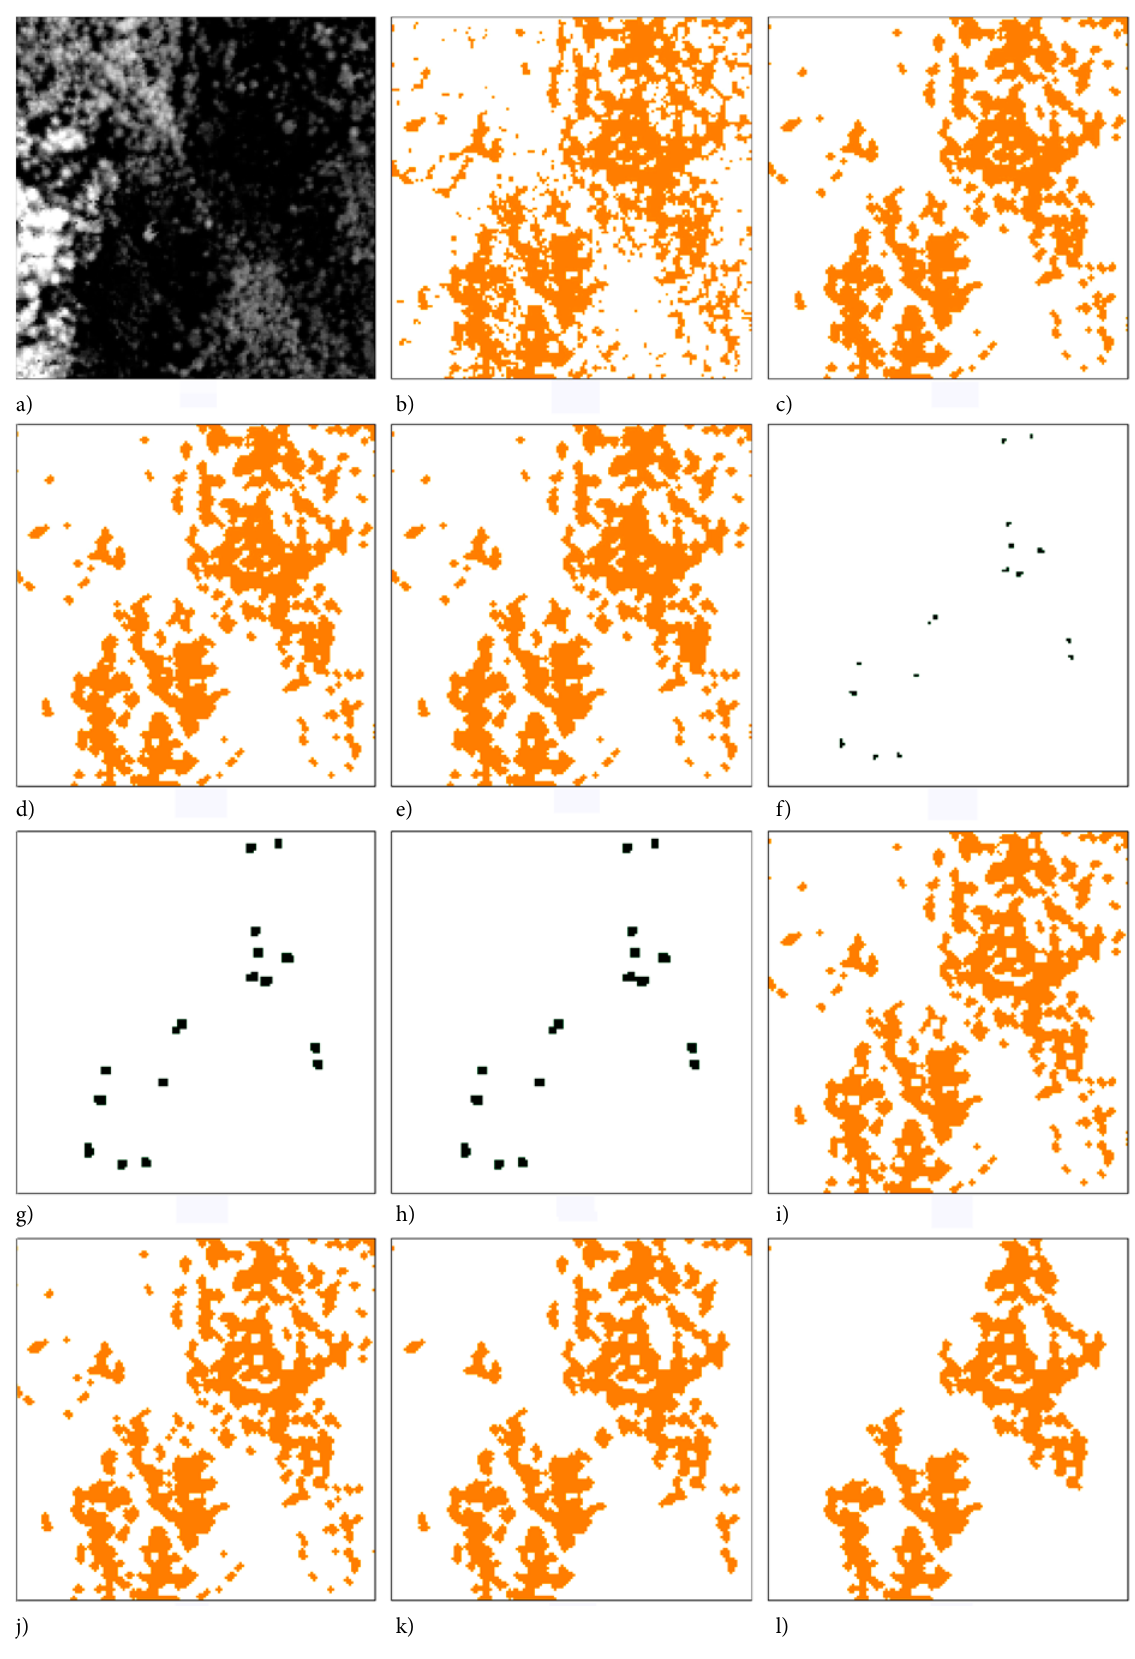
Fig. 6. Results of each processing step in the mapping of areas with no tree vegetation. Pixel size = 1.5 m, image portion size = 225 m × 225 m. For the explanation of each step (a-l), see Section